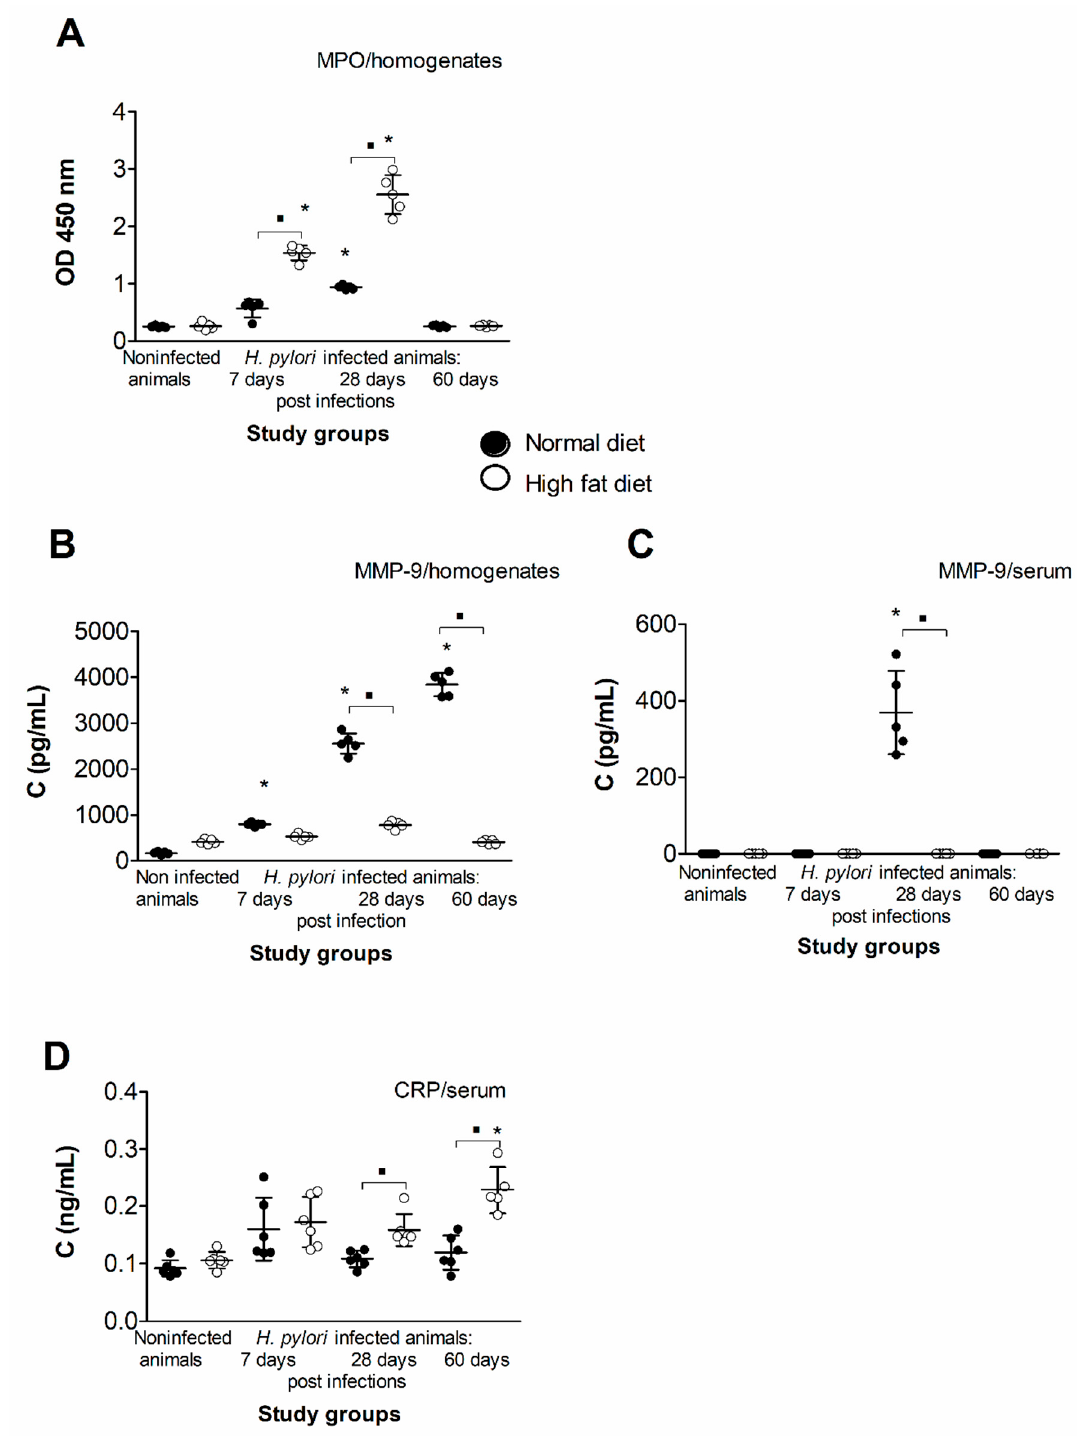
Figure 3. Detection of myeloperoxidase (MPO) ( A ) and metalloproteinase (MMP)-9 ( B ) in the gastric tissue and the level of MMP-9 ( C ) and C-reactive protein (CRP) ( D ) in the serum of uninfected or H. pylori -infected guinea pigs at 7, 28 and 60 days from inoculation. Animals were exposed to normal chow or an experimental high-fat diet. Five animals per group were examined. The results are presented as the median values. Statistical analysis was performed with the nonparametric Kruskal–Wallis test. Statistical significance, * p < 0.05 was obtained for H. pylori -infected animals fed a normal chow or a high-fat diet vs. the control animals, ▪ p < 0.05 was obtained for H. pylori -infected animals fed a normal chow vs. high-fat diet.